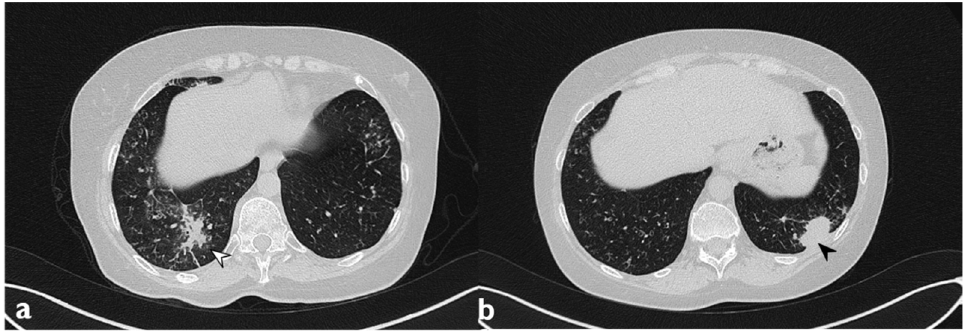
Figure 9. Migratory infiltrates. On the left ( a ): baseline HRCT; subpleural consolidation in the right lower lobe (white arrowhead). On the right ( b ): HRCT after 13 months of steroid therapy; the consolidations have disappeared in the first site, appearing in the left lower lobe (arrowhead). Table 5. Evolution of the 18 patients who presented consolidations.